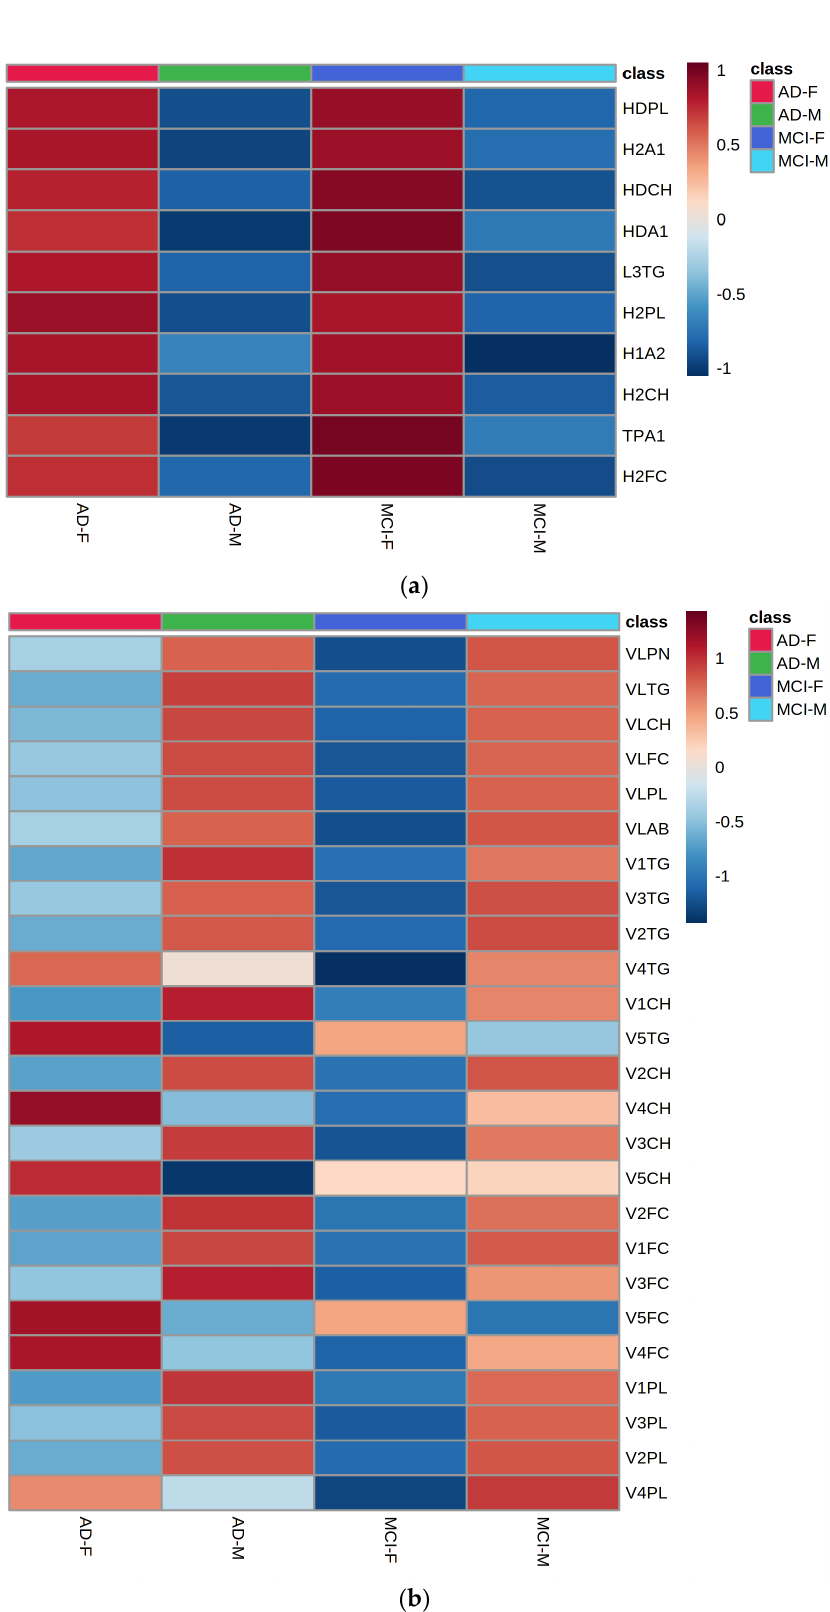
Figure A3. Heatmap plot analysis based on male−female comparisons within patient groups (AD, Con, and MCI) for the dataset from the whole cohort lipoprotein data and a selection of the top−10 features for females (Panel ( a )) alongside illustration of the VLDL parameters that were high in male groups (Panel ( b )).